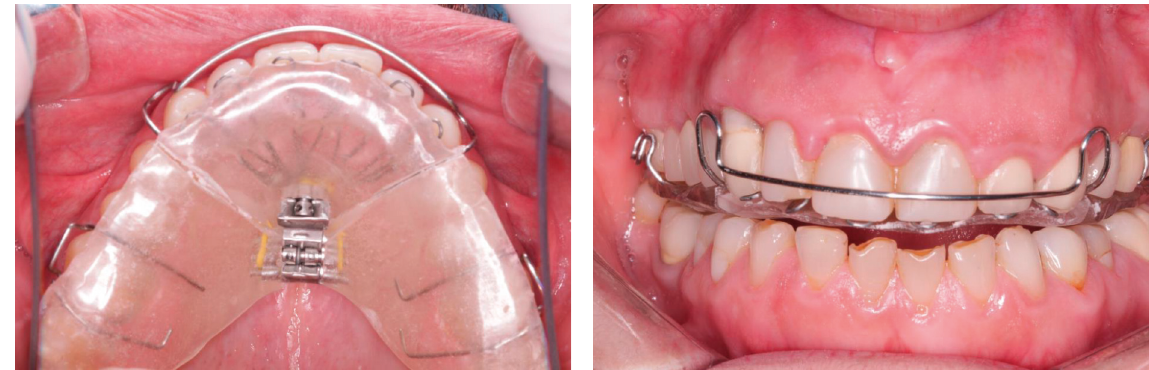
Figure 1: The acrylic-based DNA appliance ® used in this study showing 6 (patented) anterior 3-D axial springs ® , a midline screw, posterior occlusal coverage, retentive clasps, and a labial bow. Note: other designs are customized depending on patient Table 1: Scores distribution of Epworth Sleepiness Scale before and after BOAT treatment. Before treatment, N (%) After treatment, N (%) Normal (scores 1–10)